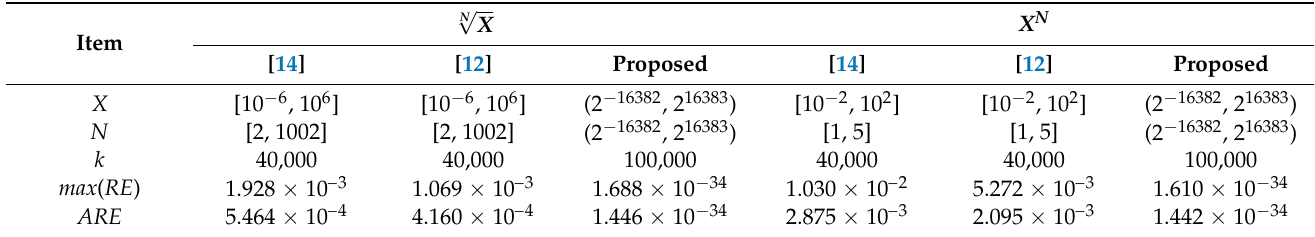
Table 4. Verification of [12,14] and the proposed architecture by Python simulation.